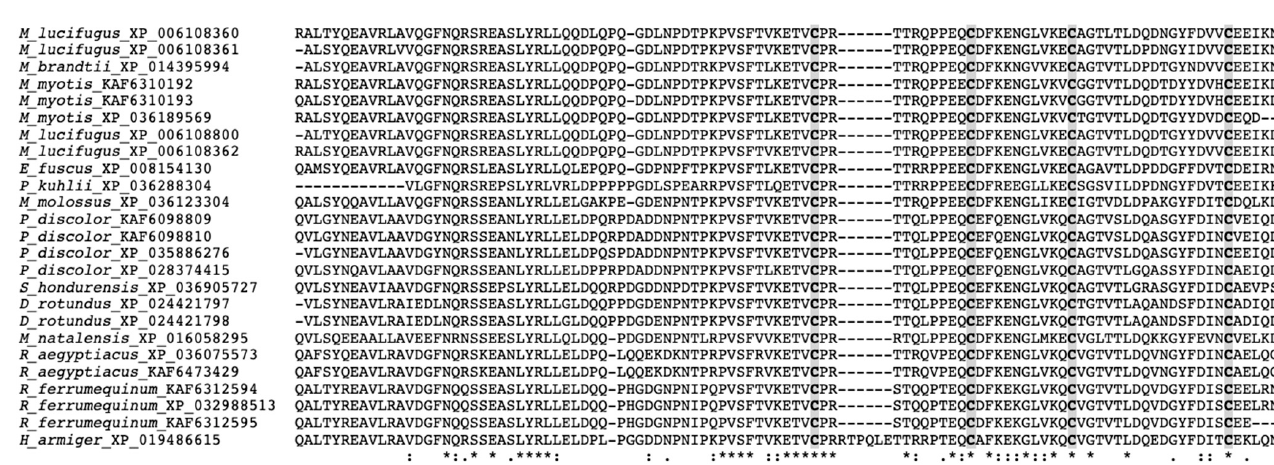
Figure 1. Multi-sequence alignments of the conserved cathelin region of bat cathelicidins using the default parameters of CLUSTALW (https://www.genome.jp/tools-bin/clustalw, accessed on: 10 January 2021). Gaps are inserted to optimize the alignment. Conserved cysteines are shaded and identical amino acids are indicated by asterisks, whereas those with high or low similarities are indicated by colons and dots, respectively.